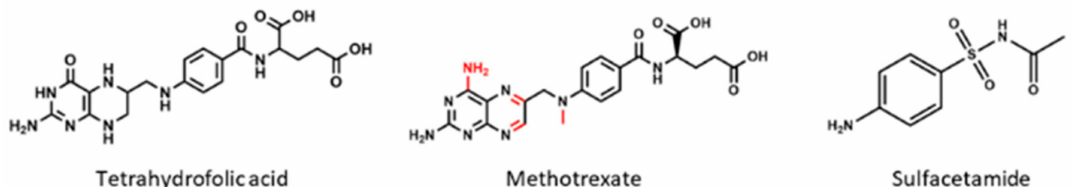
Figure 1. Chemical structures of tetrahydrofolic acid and two antifolates: methotrexate (classical antifolate) and sulfacetamide (non-classical antifolate), commonly used as folic acid antagonists. Di ff erences between tetrahydrofolate molecule (THF) and methotrexate are pointed out in red.